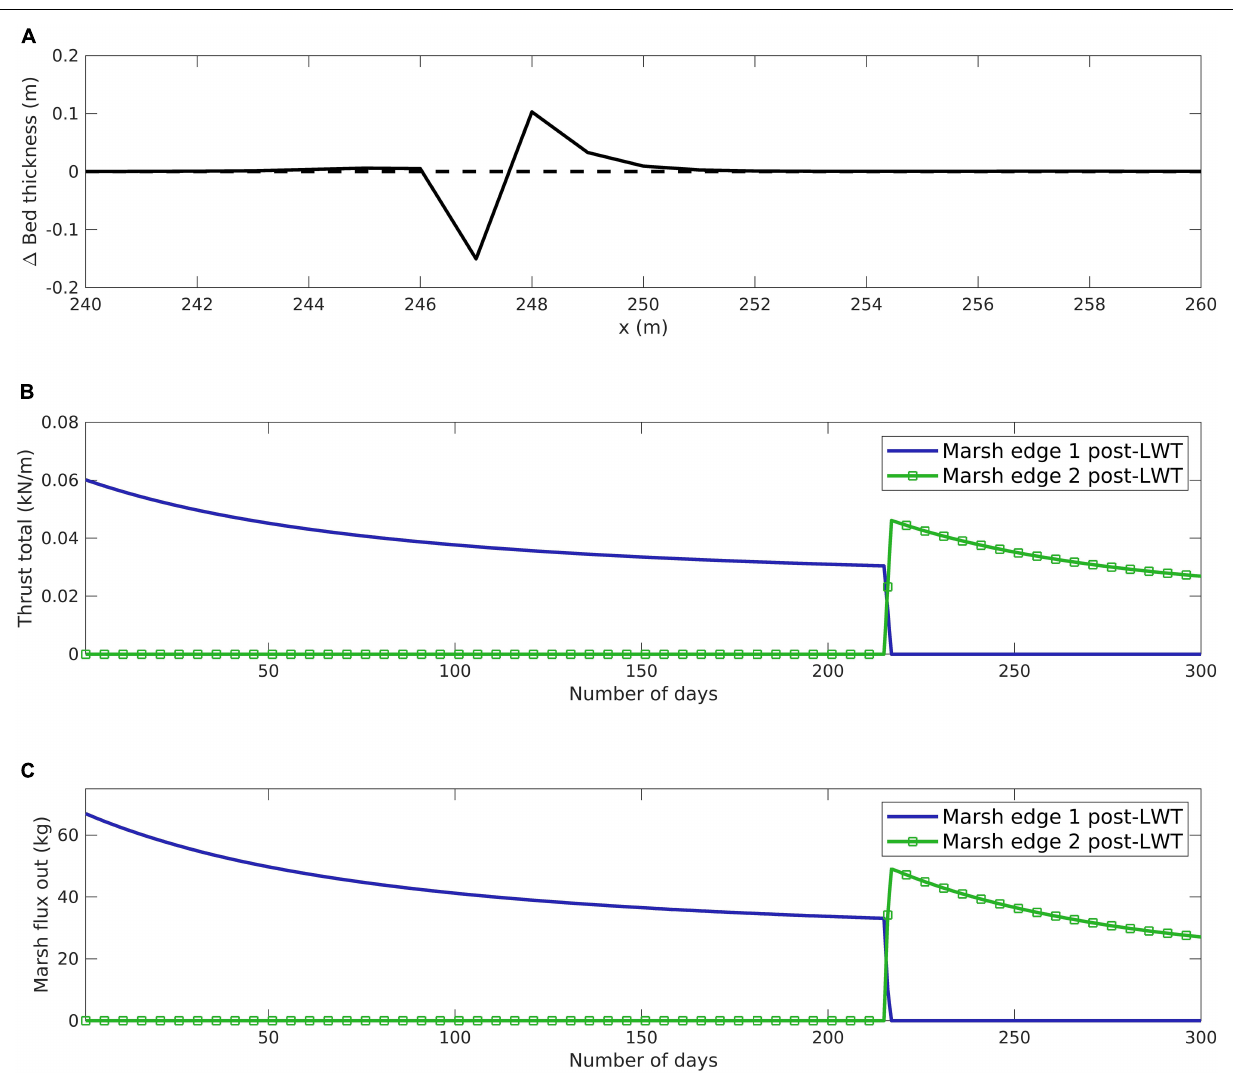
Frontiers in Marine Science |